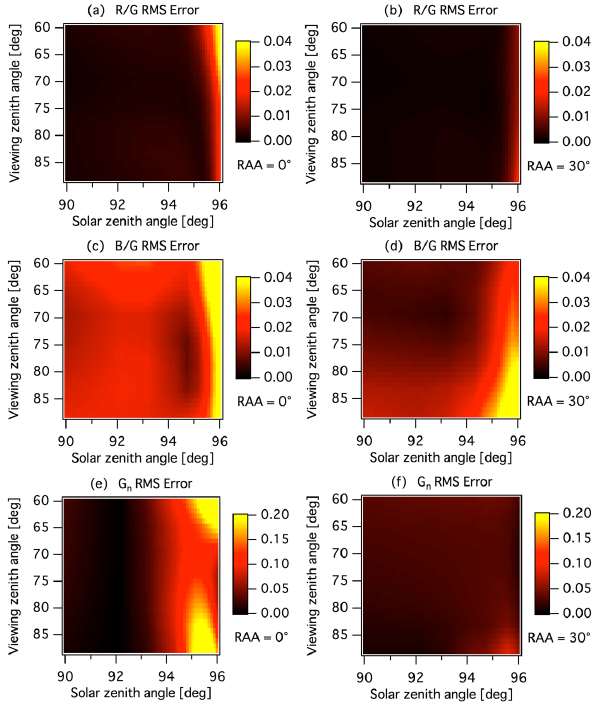
Figure 8. Forward model errors (absolute values) in (a, b) R / G, (c, d) B / G, and (e, f) G n caused by uncertainties in the model pa- rameters as functions of SZA and VZA. Panels on the left (a, c, e) have RAA = 0 ◦ , and those on the right have RAA = 30 ◦